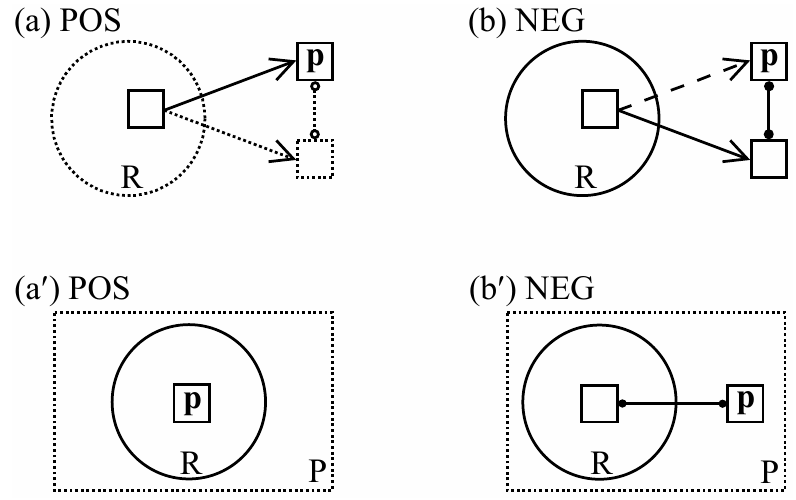
Figure 10. Polarity at the basic level.